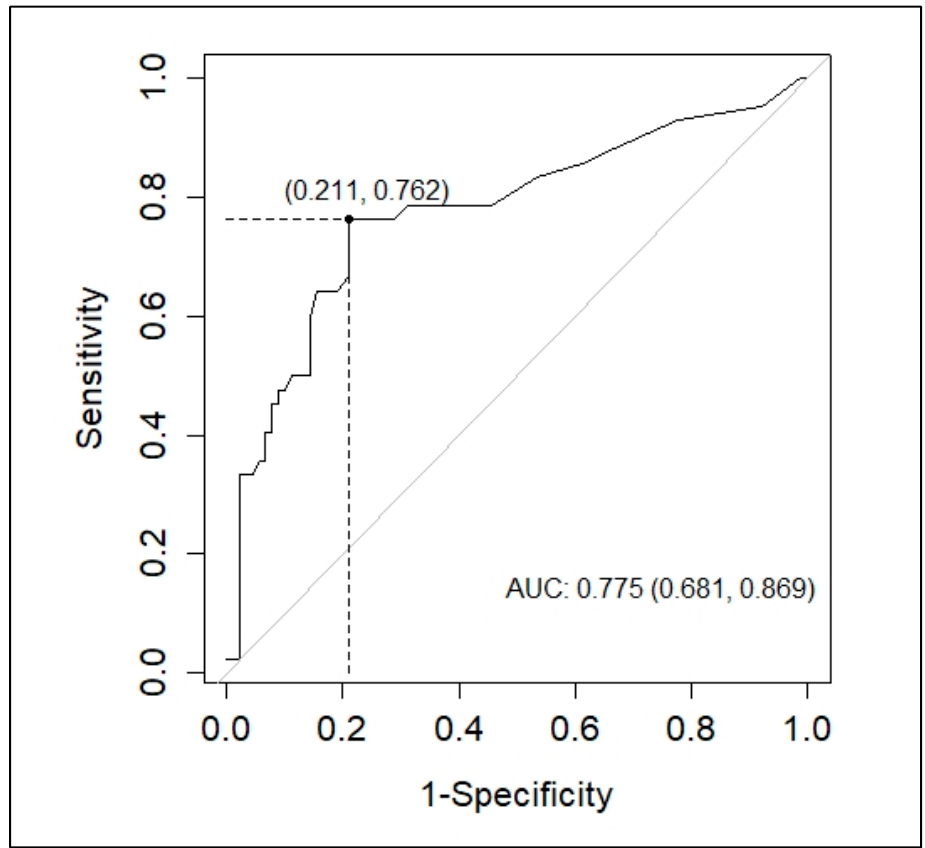
Figure 3. Receiver operating characteristic (ROC) of aspartate aminotransferase-to-platelet ratio index (APRI) for distinguishing DwWS/SD patients. The optimal cutoff point was determined using the Youden index.